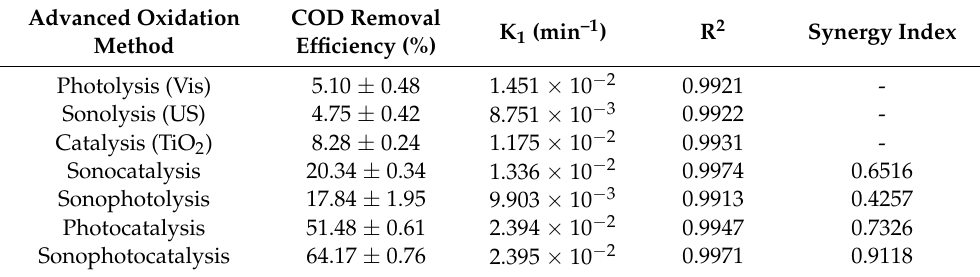
Table 3. COD removal efficiency, kinetic rate constant, coefficient of determination, and synergy index of different advanced oxidation processes for COD removal from